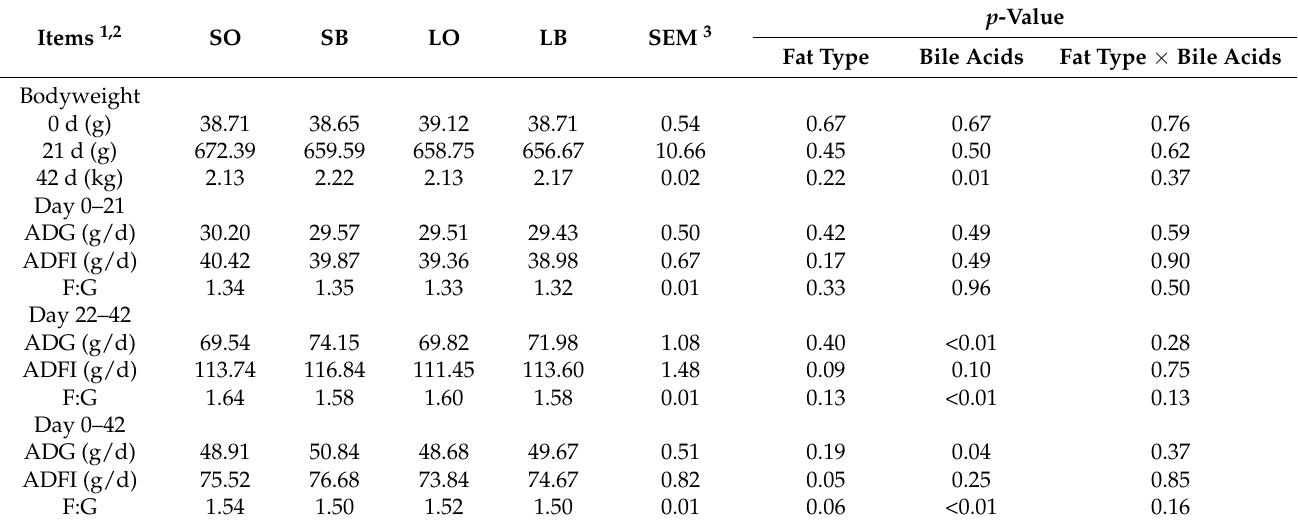
Table 3. Effects of bile acids supplemented in diet included with different types of fat on growth performance in broiler chickens.